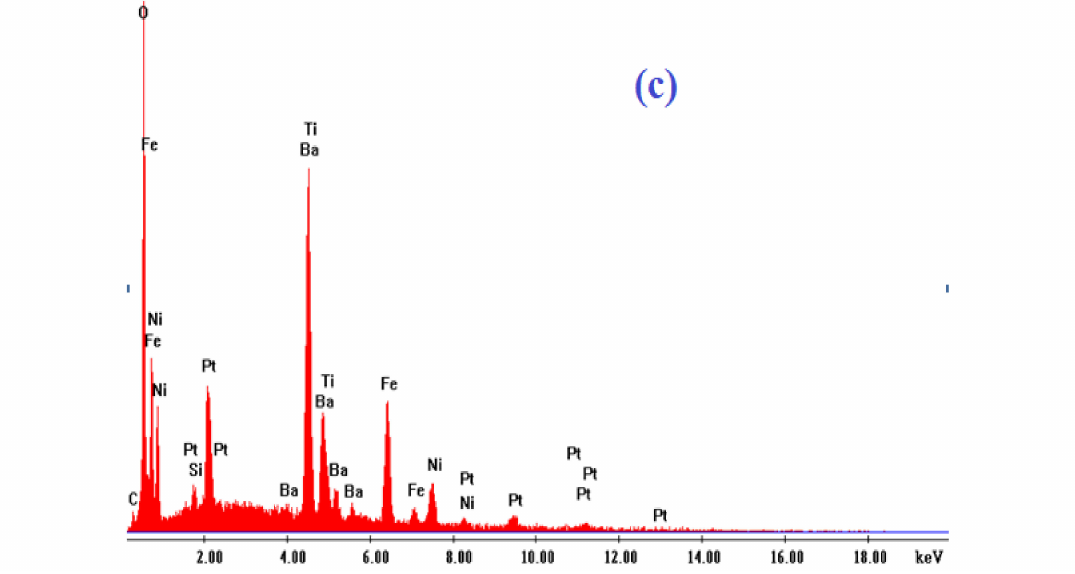
Figure 3. ( a ) Surface FE-SEM image. ( b ) Cross-sectional SEM image. ( c ) EDX image of the grown (BTO/NFO/BTO) tri-layered thin film on substrate Pt(111)/Ti/SiO 2 /Si at room